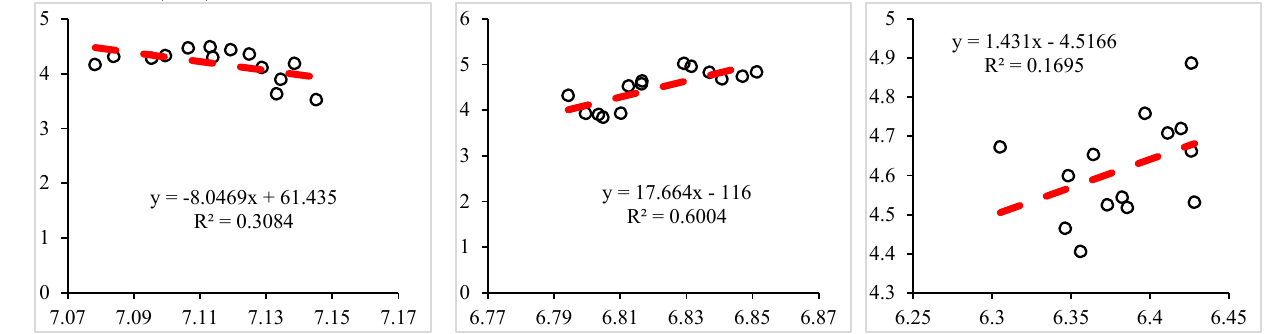
Figure A2. Allometric growth fitting results of urban resilience indicators in Beijing, Fuzhou, and Urumqi from 2006 to 2019.